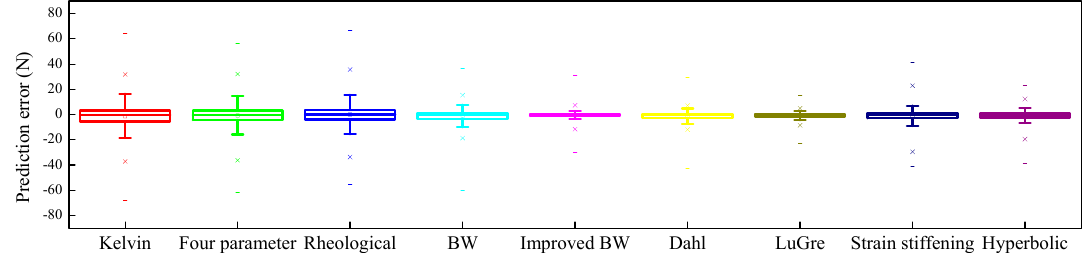
Figure 31. Prediction error distribution.